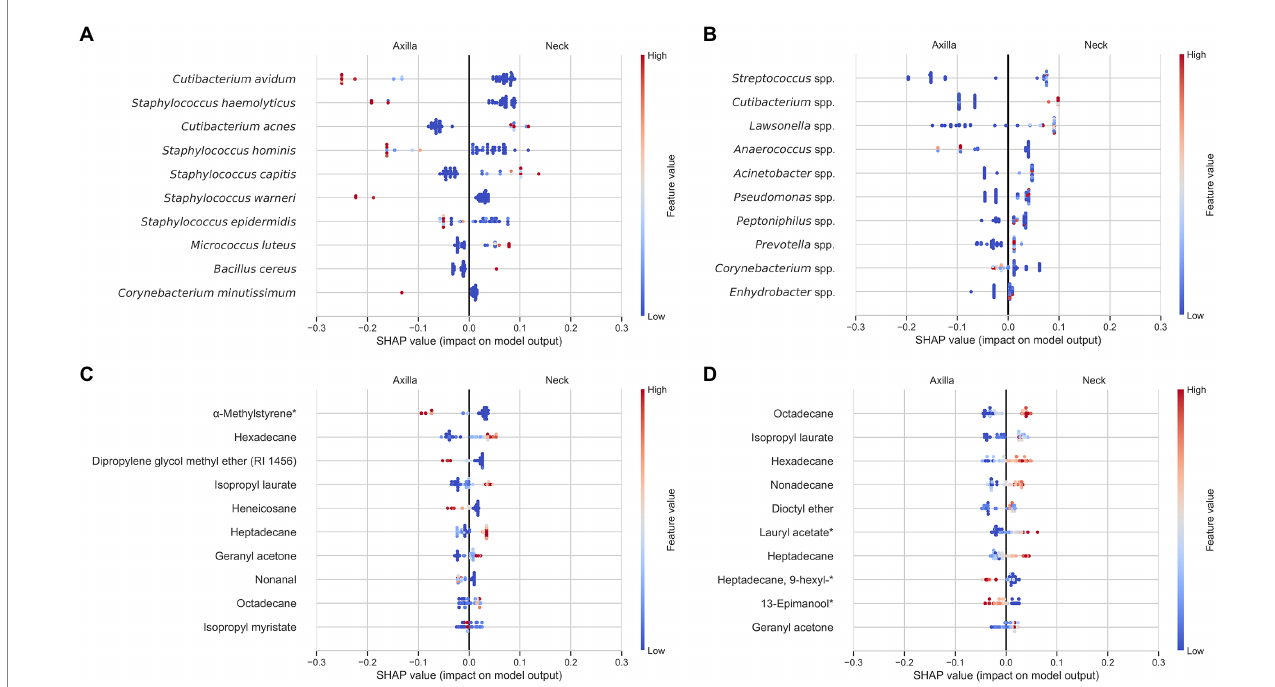
FIGURE 6 Feature importance of the individual data sources [culture data (A) , ASV data (B) , GC–MS FFAP (C) and DB-5 (D) ] of a random forest classifier to differentiate between axilla and neck samples. GC–MS data was not normalized with the total peak area, as this resulted in a higher accuracy for the classifier trained on DB-5 data. The abundance of the features is color coded where low abundance is shown with blue colors and high abundance with red colors. Features that indicate armpit samples are in the left half of the plot while features that indicate neck samples are on the right. Example: High abundance of octadecane in (D) is indicative of neck samples (considerable number of red dots), whereas low abundance is indicative of axilla samples (considerable number of blue dots). The individual features are shown on the y-axis. Every point in the plot is the abundance value of a feature from a single